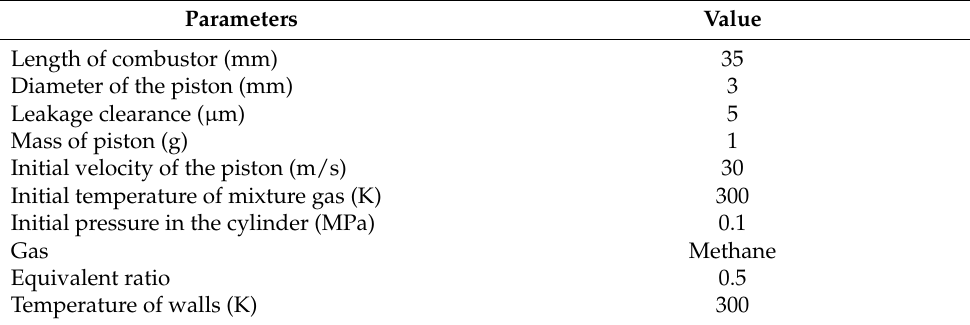
Table 2. The settings of the initial simulation conditions.